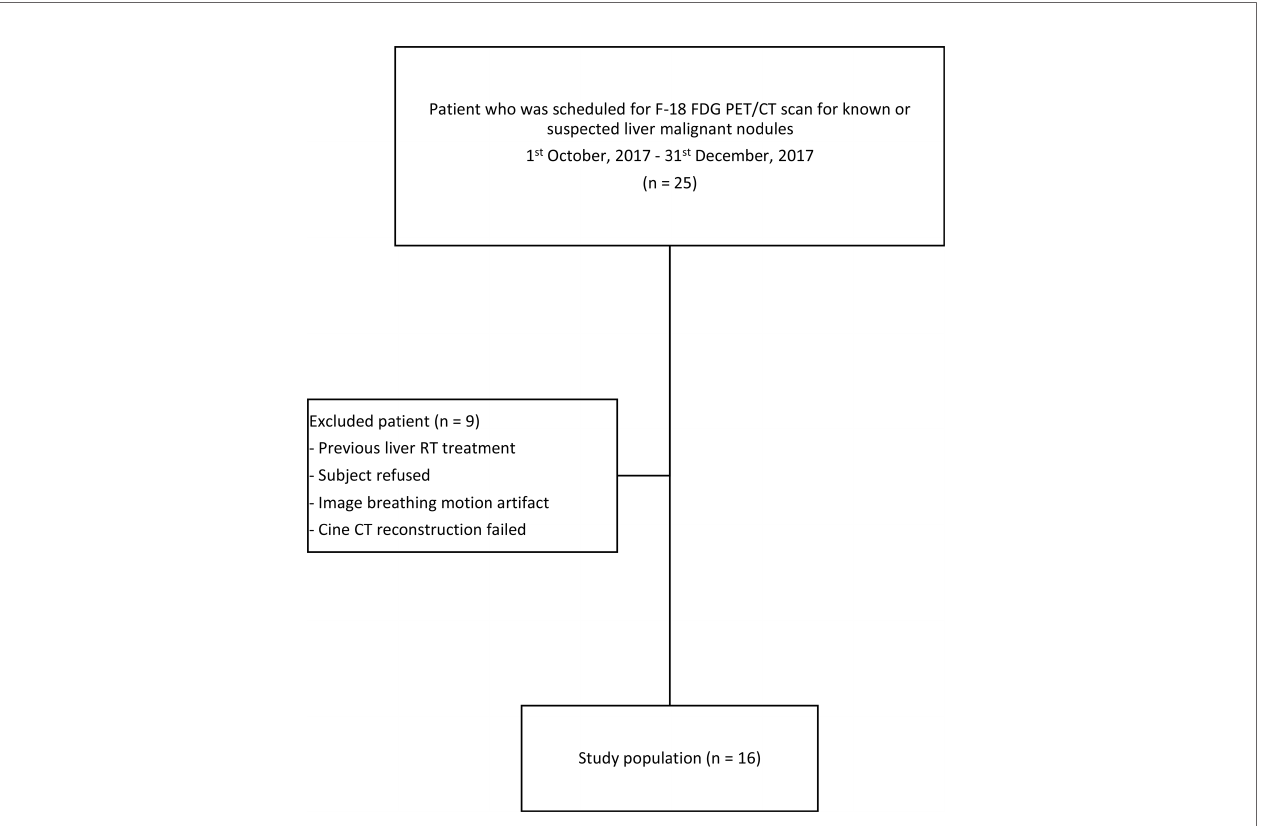
FIGURE 2 | Chart on recruitment and fi nal study